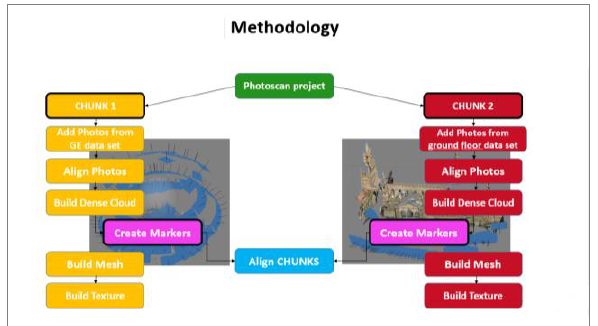
Figure 4. The Photoscan project with two